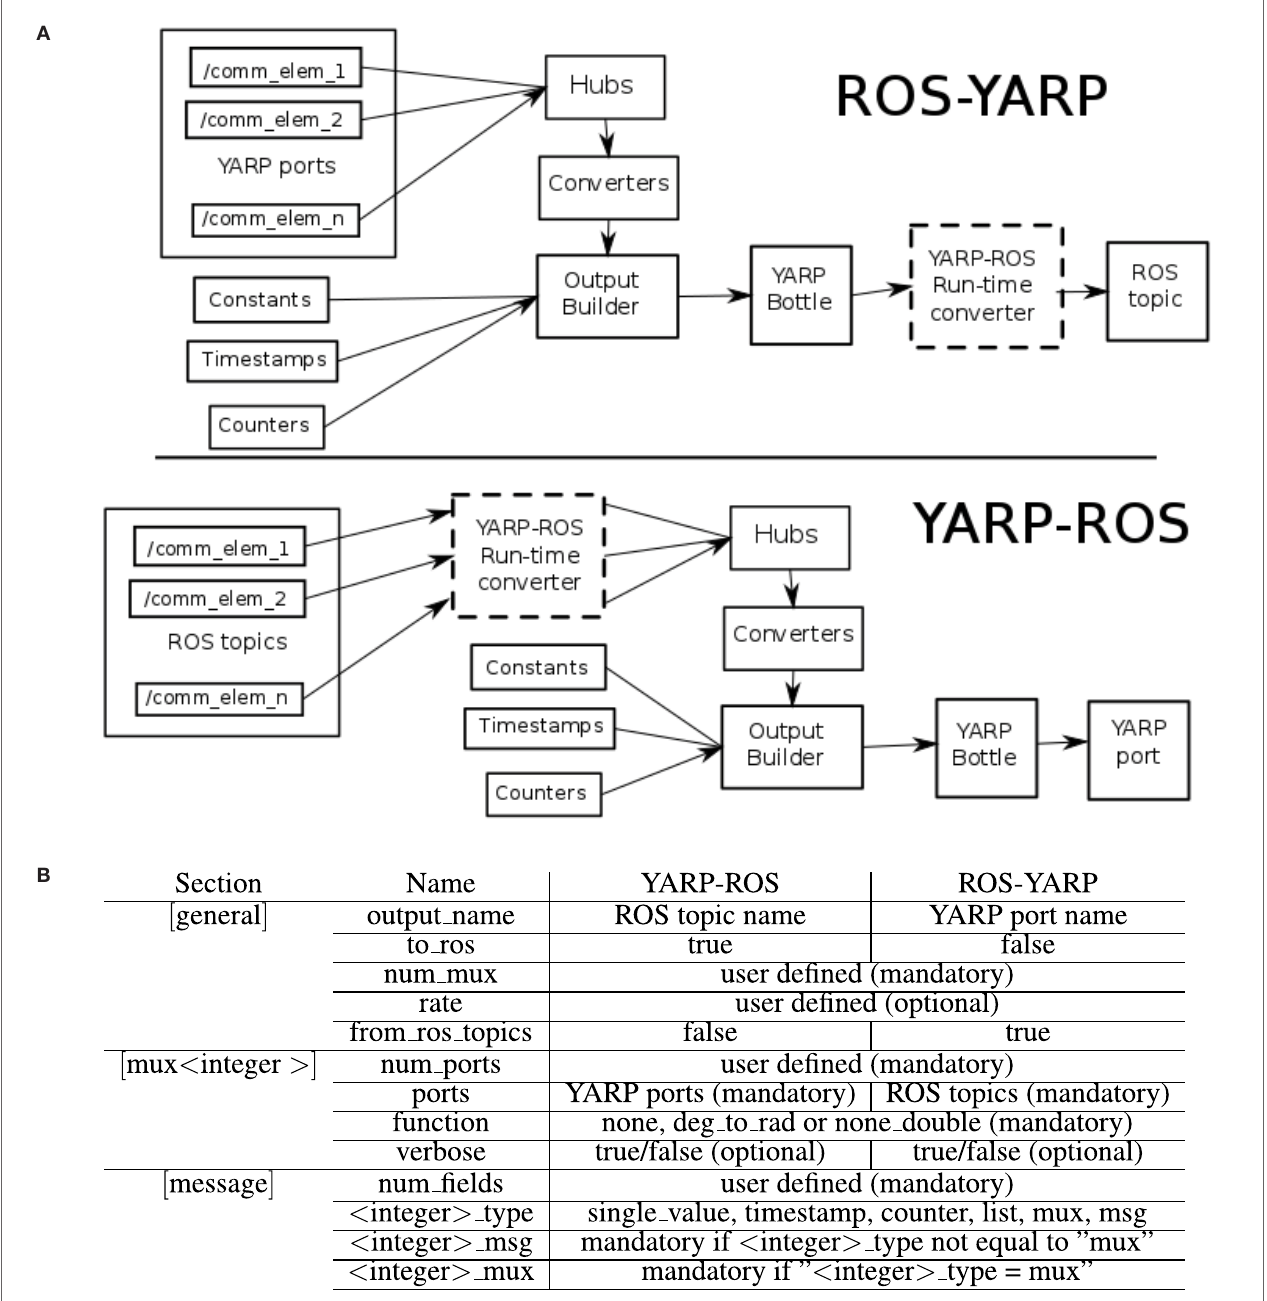
FIGURe 1 | Top image shows the architecture of the generated code . Bottom table shows the overview of the configuration parameters. (A) Generated code detailed architecture for the main use cases. The dashed boxes represent the previously implemented YARP with ROS Fitzpatrick (2016) interoperability tools. (B) Overview of configuration file parameters. If the message section has a hierarchical structure, additional sections must be added and the instructions on how to do this are available online (see text footnote